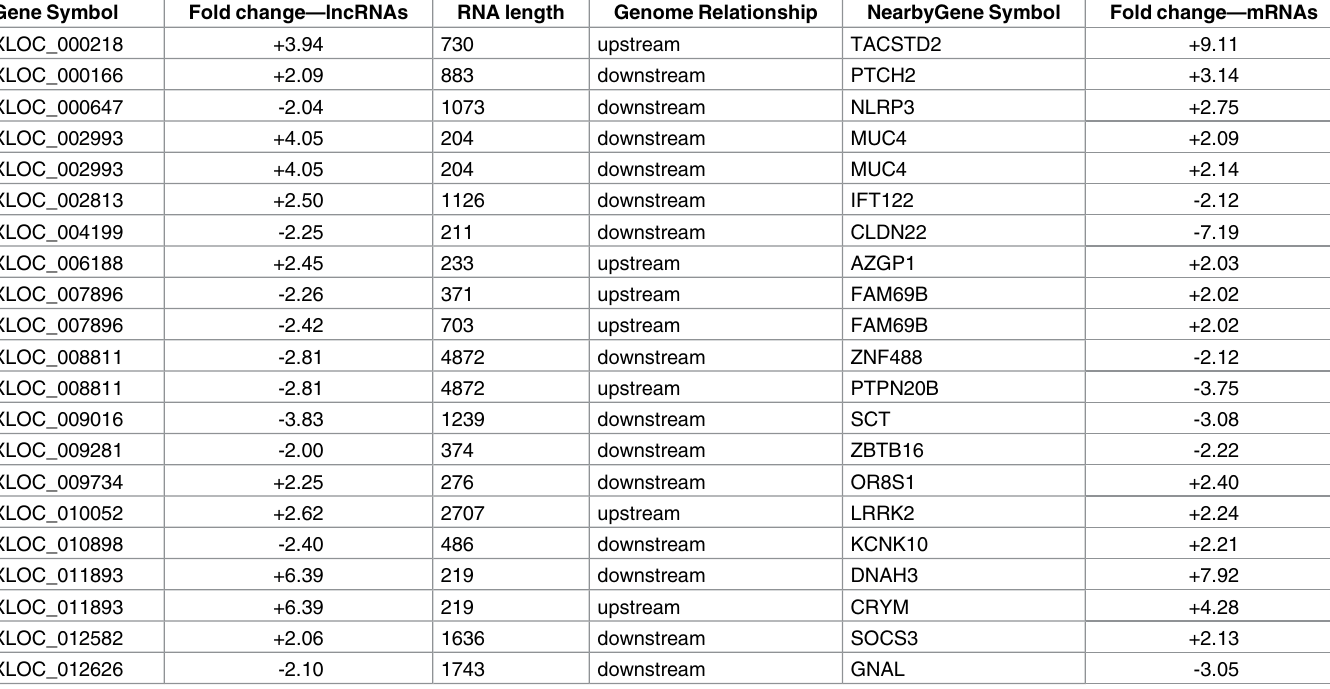
Table 4. Deregulated lincRNAs and associated coding gene pairs (distance < 300 kb). Gene